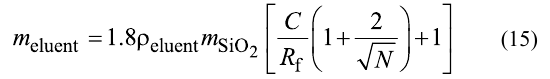
Considering that the solvent used to pack the column is general- ly recycled, the volume of eluent required can then be expressed by Equation